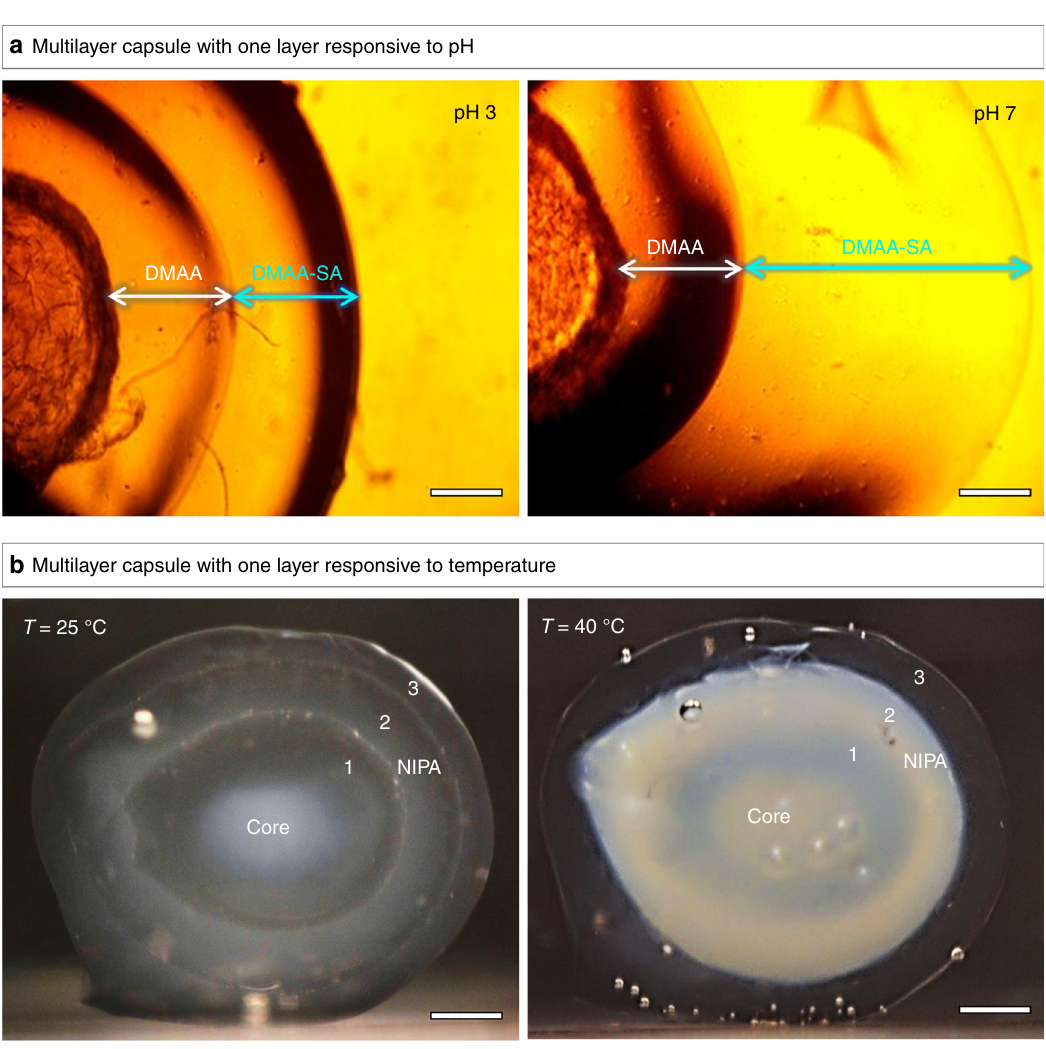
Fig. 5 Multilayer capsules with speci fi c layers responsive to external stimuli. In a , a two-layer capsule is shown with an inner layer of nonionic polymer (DMAA) and an outer layer of anionic polymer, obtained by copolymerization of DMAA with sodium acrylate (SA) (designated as DMAA – SA). At pH 3, the two layers have the same thickness. At pH 7, the carboxylate groups in the DMAA – SA layer become deprotonated, causing the anionic gel to swell, and thus the thickness of the DMAA – SA layer increases substantially. In b , a three-layer capsule is shown, where layers 1 and 3 are DMAA (non-responsive), while layer 2 is NIPA (thermoresponsive). At ambient temperature (25 °C), all layers are transparent gels. Upon heating to 40 °C, which is above the lower critical solution temperature (LCST) of NIPA, the NIPA layer becomes turbid. Scale bars are 500 µ m in a and 1 mm in